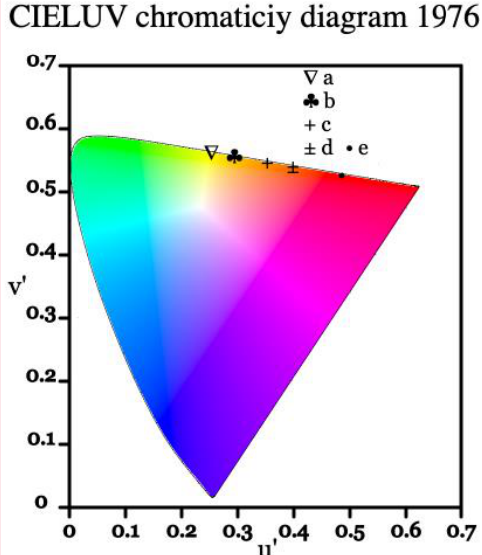
Figure 8. CIE 1976 representation of significant emission lines from the 5 D 0 level in Eu:BSO, where points from a to e represent significant peaks. Point a represents the 5 D 0 → 7 F 0 transition, points b to d represent the 5 D 0 → 7 F 1 transition, and point e represents the 5 D 0 → 7 F 2 transition.